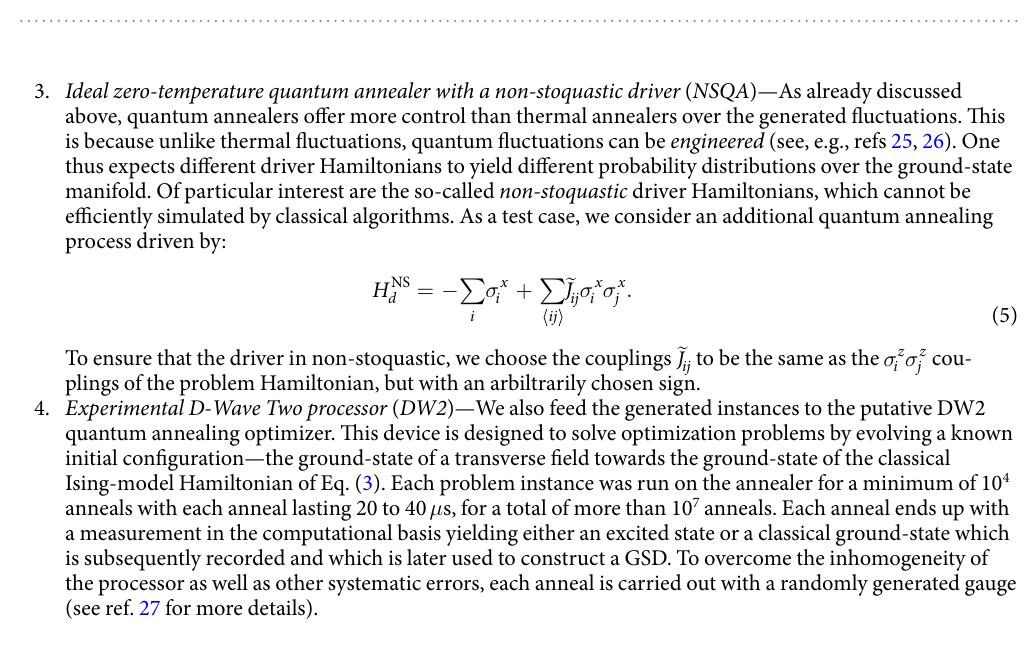
— Table 1. Fraction of instances with statistically significant differences in GSD between any two optimizers. Here, the p -value is set at p =